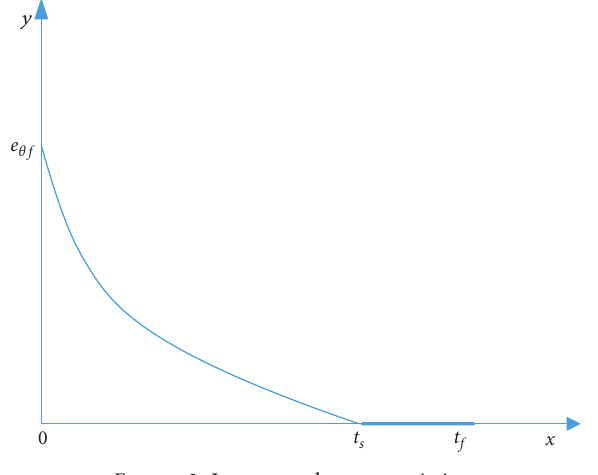
Figure 3: Impact angle error